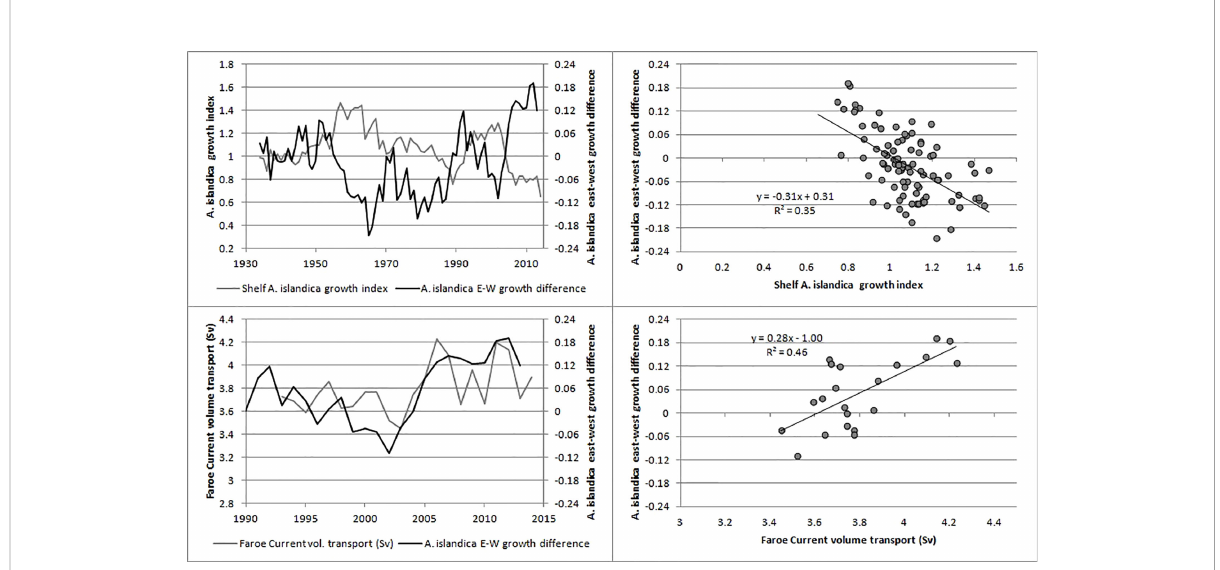
FIGURE 3 The difference in growth of A. islandica between eastern (E, N) and western sites (S, K). The sites were arranged in an eastward direction as the sequence S-K-E-N with x-coordinates 1 to 4 and y-coordinates equal to the A.islandica growth. The difference in growth between eastern and western sites was, for each year separately, quanti fi ed as the slope of the regression line between y and x. Upper: compared with the shelf A. islandica growth index (sites KES). Lower: compared with the Faroe Current volume transport.